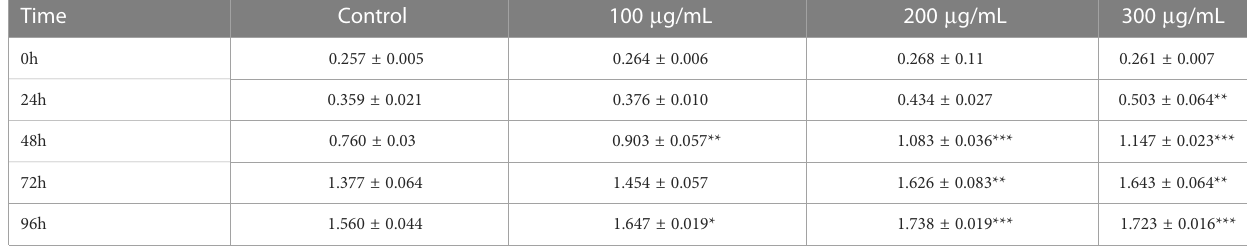
TABLE 3 CCK8 detected that chitosan oligosaccharides showed a dose and time-effect relationship to promote the proliferation of KGN cells. Time Control 100 m